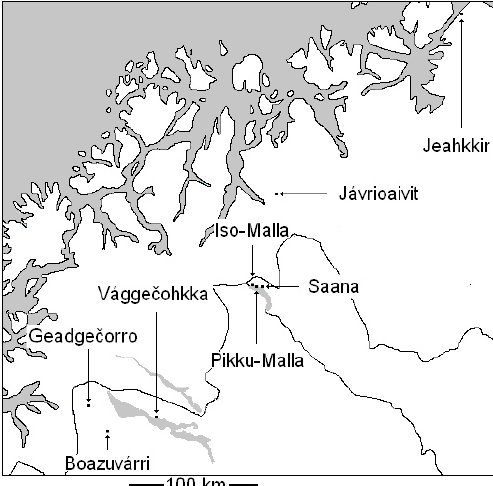
Fig. 2. Map over the study area, showing the locations of the study sites in northernmost Fennoscan- dia (Boazuvárri, Geadgečorro and Vággečohkka in Sweden; Pikku-Malla, Iso-Malla and Saana in Finland; Jávrioaivit and Jeahkkir in